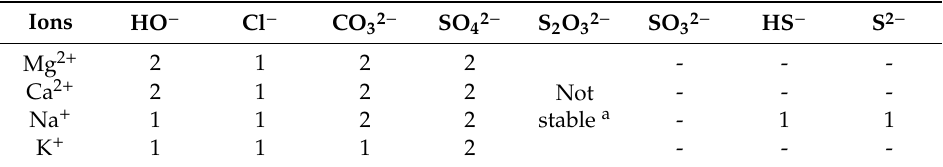
Table 4. Classification of salts commonly found in black liquor. Based on Rumyantsev [70] and Wang et al. [71]. Note that this classification stands for pure salt in supercritical water, and that a mixture of salts may behave completely di ff erently than the individual salts. Salts with unknown phase behaviors are marked with a dash